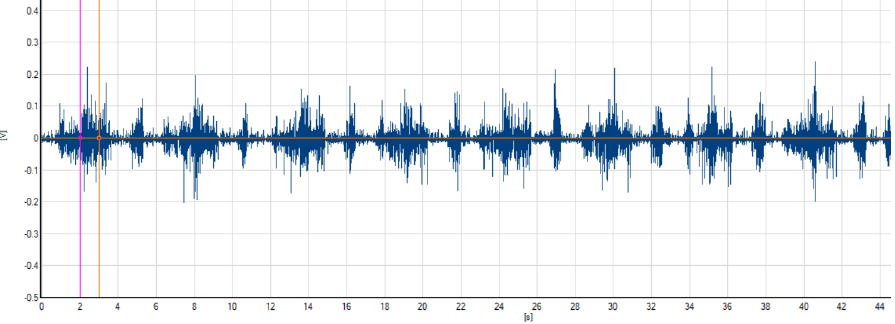
Figure 2. Raw EMG